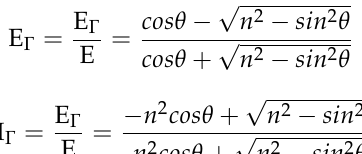
angle ( Ɵ 2 ) for transmission (T) [30].